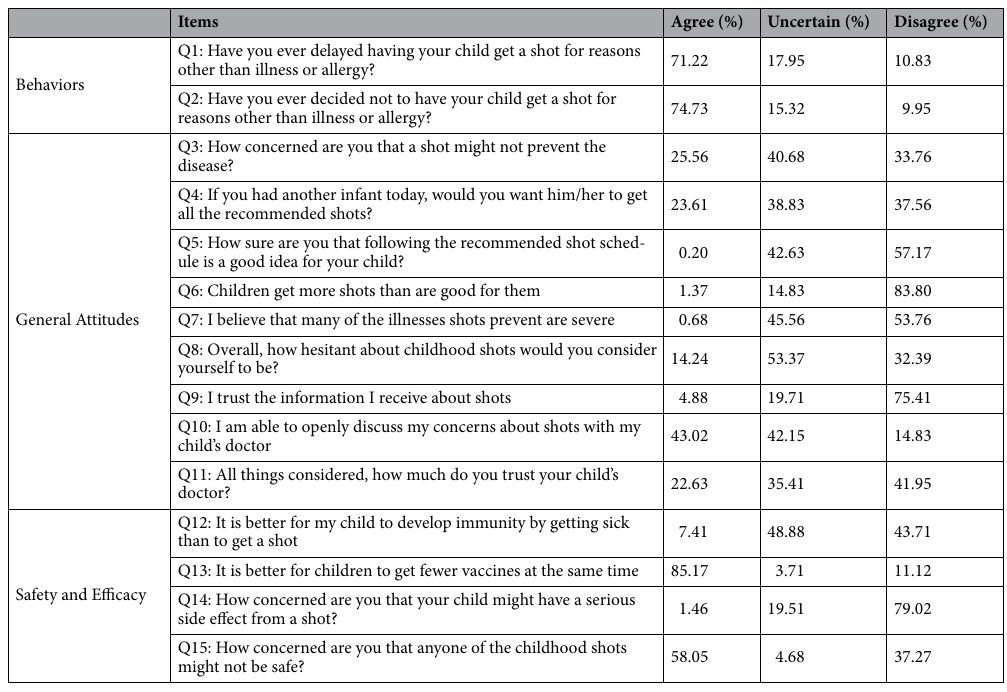
Table 2. Current situation of vaccine hesitation among parents of preschool